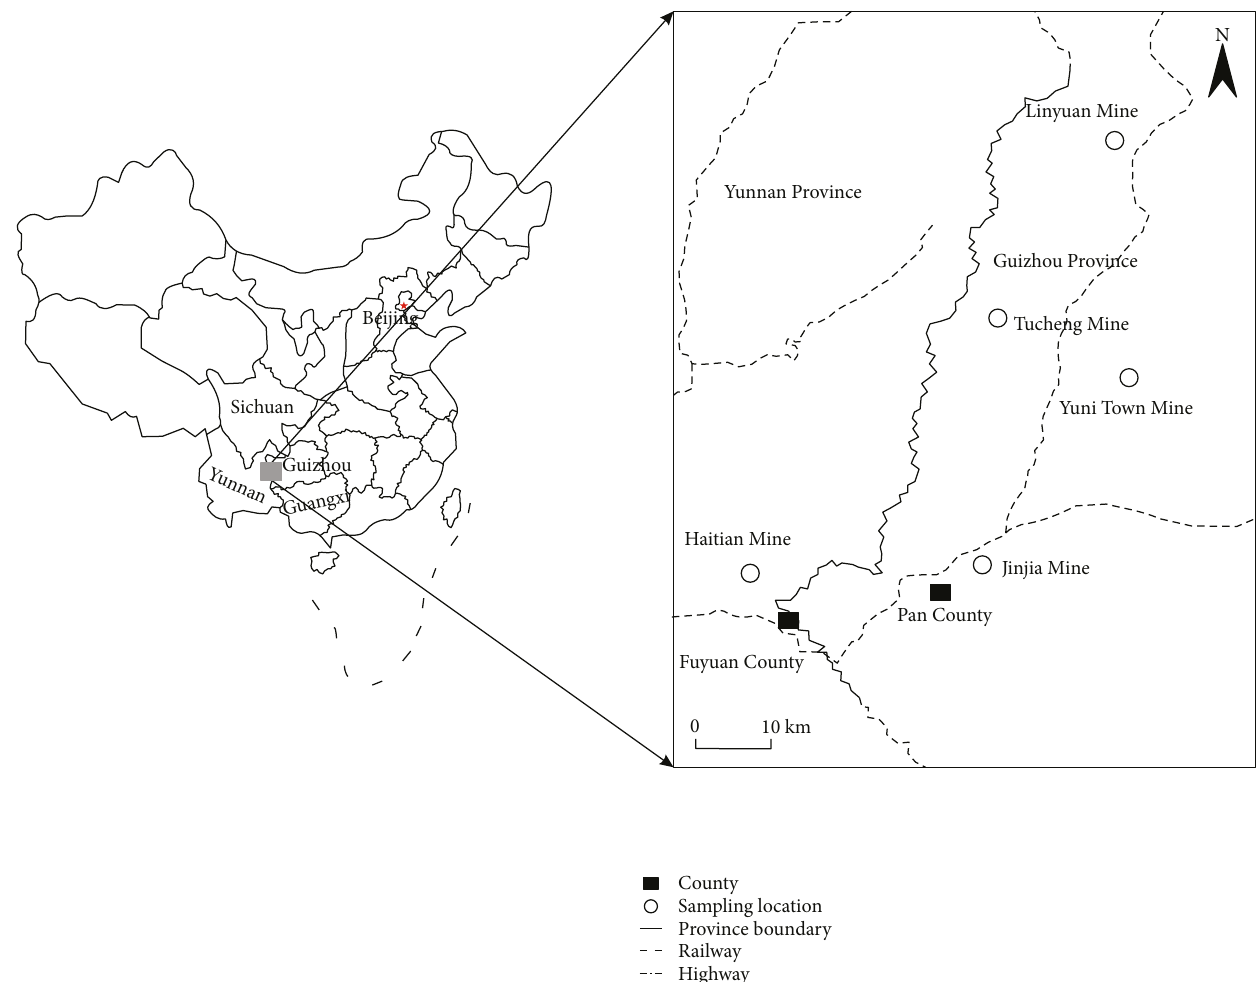
Figure 1: Locations of coalmines for coal samples collected.